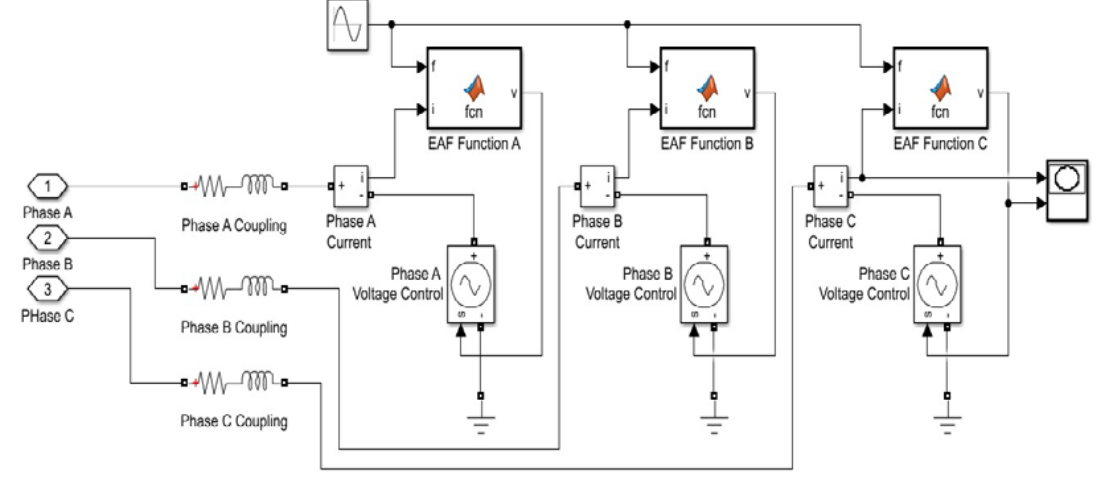
Figure 15. Circuit configuration of electric arc furnace. Table 2. Simulation parameters with the application of various loads [38].